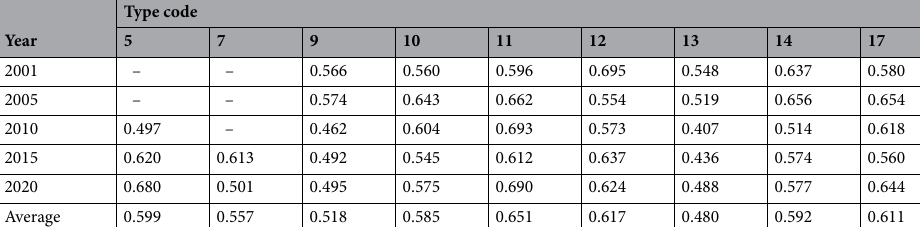
Table 11. RSEI corresponds to the type codes of X4 (confidence level 95%). Code 5 represents mixed forests; code 7 represents open shrublands; code 9 represents savannas; code 10 represents grasslands; code 11 represents permanent wetlands; code 12 represents croplands; code 13 represents urban areas; code 14 represents cropland—natural vegetation mosaic; code 17 represents water